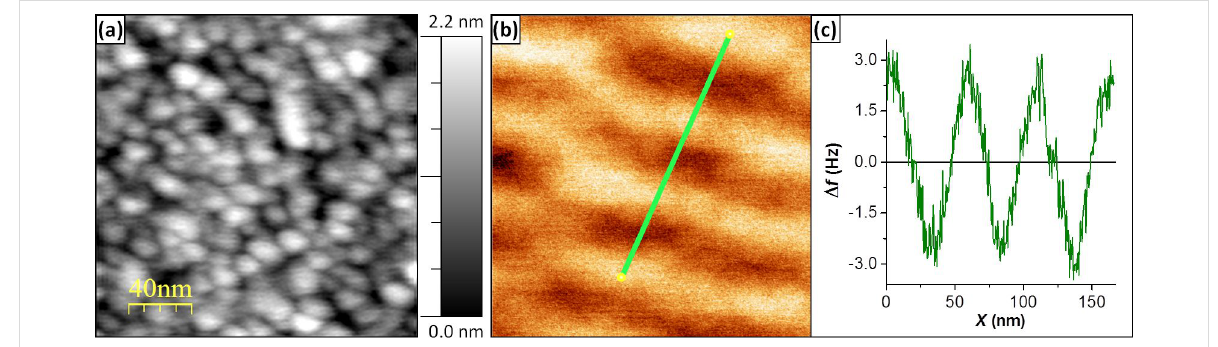
Figure 3: (a) Topography of a high-density HDD, recorded with a custom-made tip with 20 nm coating. The lateral resolution is below 10 nm. (b) Cor- responding MFM image showing single domains with alternating OOP orientations. (c) Frequency shift profile along the line shown in (b) that gives an inter-domain distance of about 25